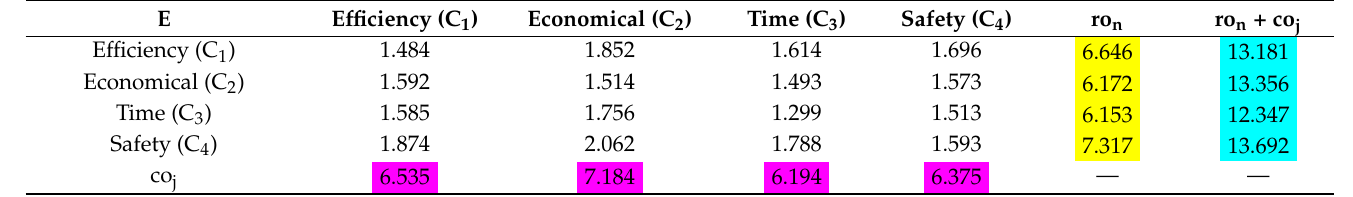
— — The ro n (highlighted in yellow) means the total given both direct and indirect effects from criteria n to the other criteria, and co j (highlighted in pink) means the total received both direct and indirect effects from other criterions to criterion j. The overall direct and indirect impact matrix E with corresponding ro n and co j values, when n equals j, (ro j + co j ) (highlighted in lime green) value, represents the centrality of criterion j. Table 16. Total direct influence matrix T between Efficiency (C 1 ) sub-criteria.